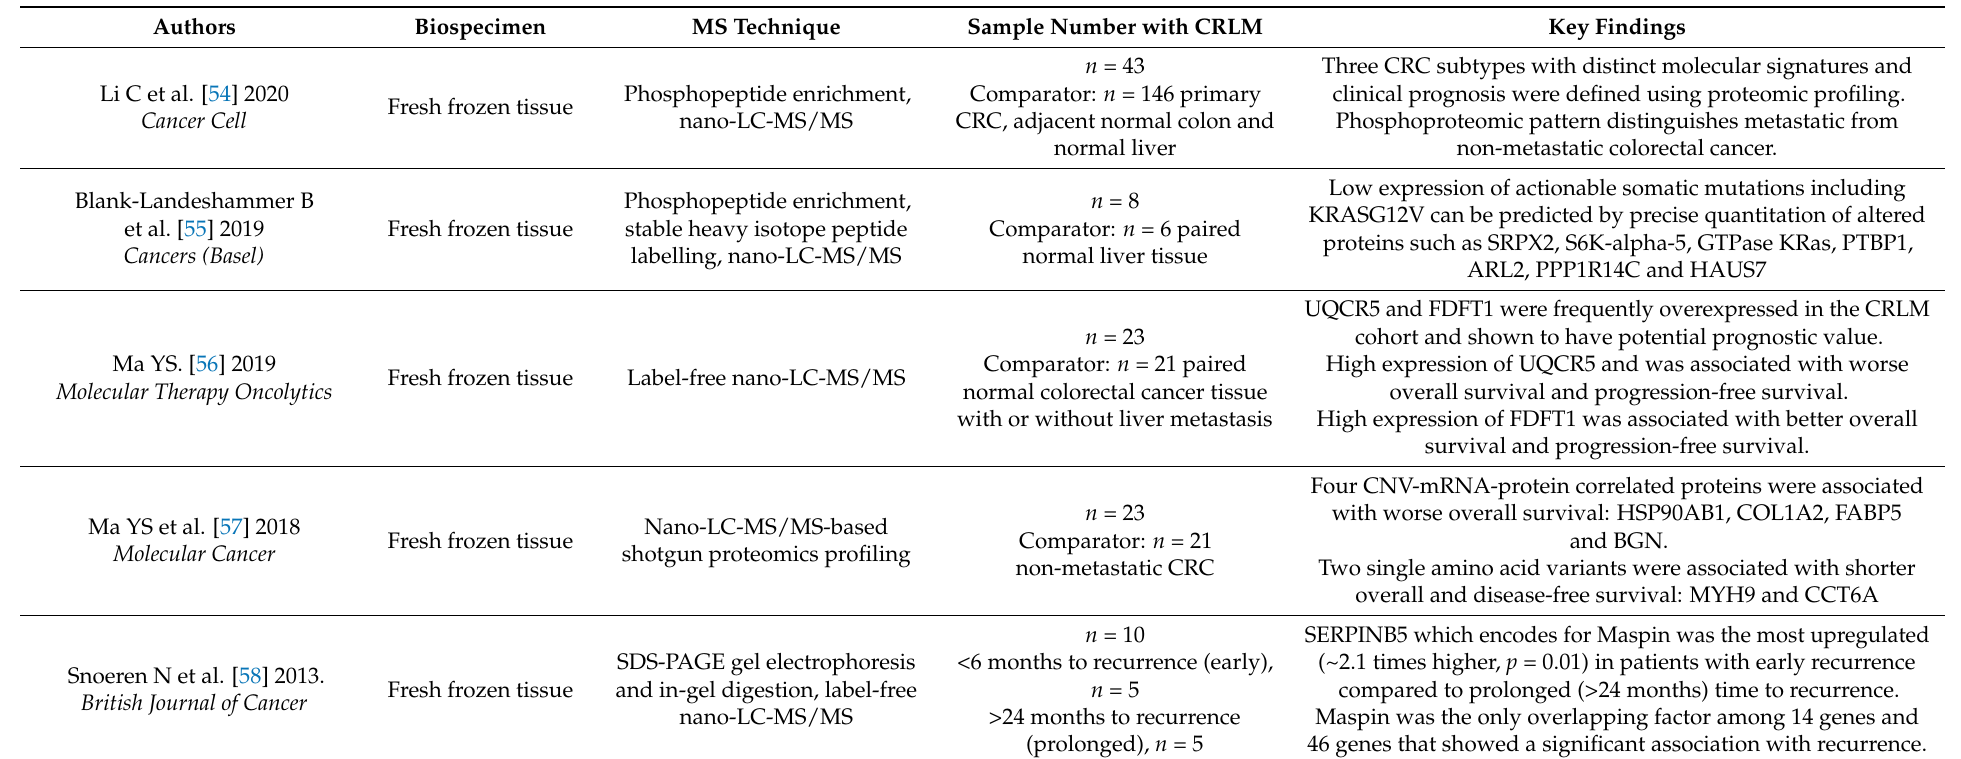
Table 2. Studies on proteogenomics of colorectal cancer liver